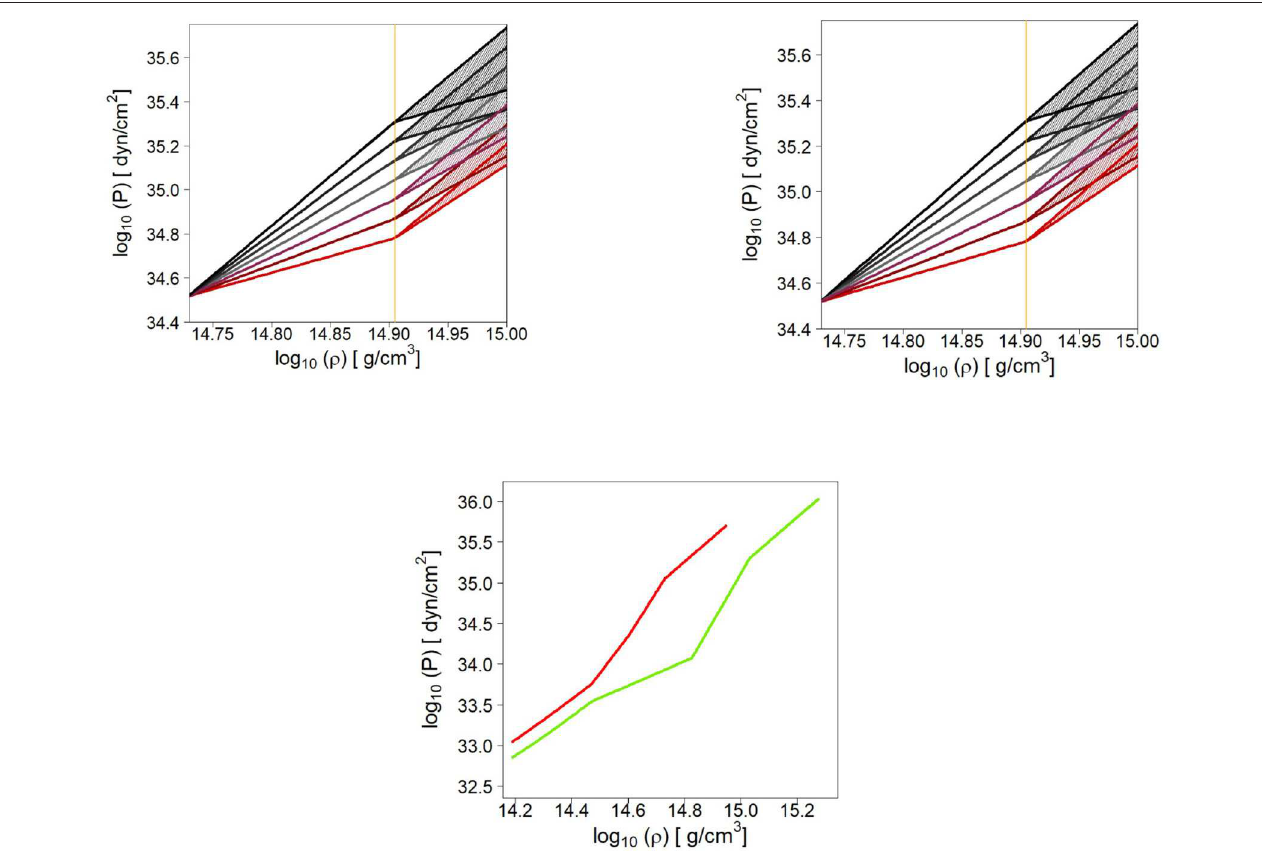
FIGURE 12 | (Top) Pressure in β -equilibrated matter vs. density at N 3 LO for 3 =450 MeV (left) and 3 =500 MeV (right) extended with polytropes as explained in the text. The vertical axis and the vertical yellow line mark the two matching densities (see text for details). (Bottom) Vaues of the pressure as a function of density taken from Table 5 of Hebeler et al. [ 178]. The lower (higher) values correspond to the “soft” (“stiff”) predictions shown in that table.